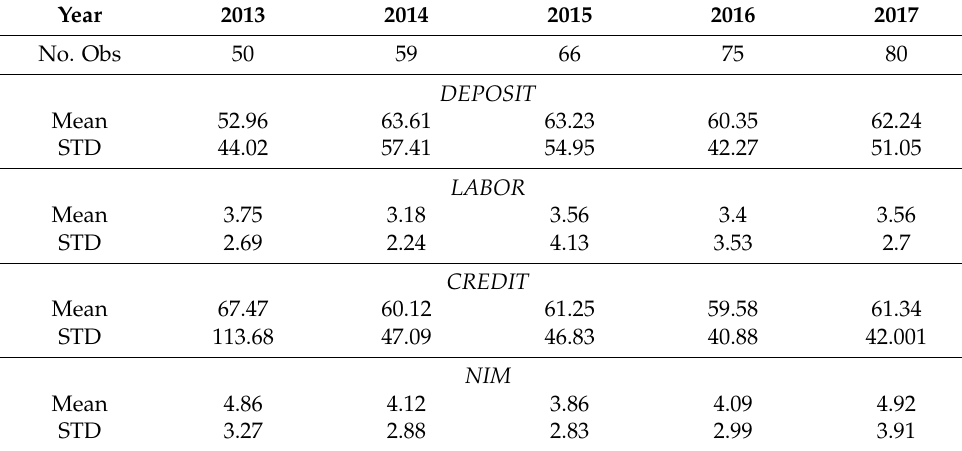
Table 1. Descriptive statistics of the inputs and outputs used in DEA